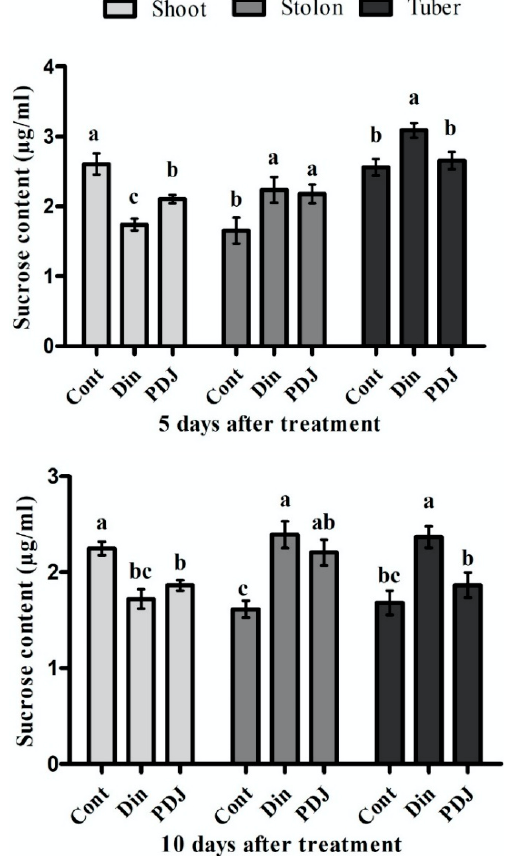
Fig. 7: Sucrose content by site per each treatment (Cont; Control, Din; Diniconazole, PDJ; Prohydrojasmon). The differences between the mean values were determined using a DMRT at P < 0.05. The results were graphically presented using GraphPad Prism (version 5.0, San Diego, CA, USA). The SAS 9.1 was used for DMRT